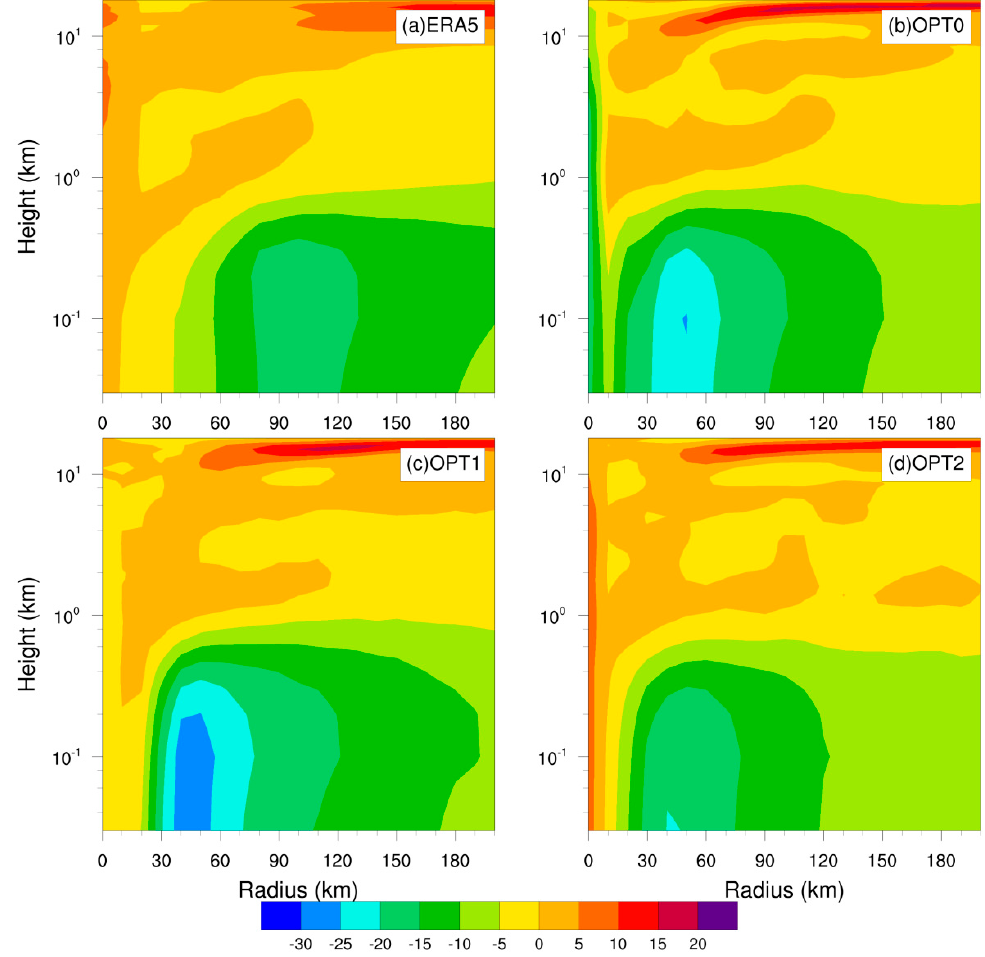
Figure 9. As in Figure 8 but for radial wind (unit: m s − 1 ). OPT1 has the strongest wind speed, including a peak tangential wind speed greater than 75 m s − 1 , peak radial inflow velocity (within boundary layer) greater than 25 m s − 1 , and peak upward velocity (along eyewall) greater than 2.2 m s − 1 . Next, OPT0 has stronger wind than OPT2, with peak tangential wind speed greater than 65 m s − 1 , peak radial inflow velocity (within boundary layer) about 25 m s − 1 , and peak upward velocity (along